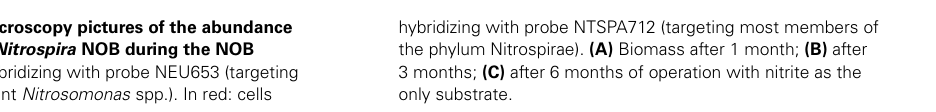
FIGURE 2 | Fluorescence microscopy pictures of the abundance of Nitrosomonas AOB and Nitrospira NOB during the NOB enrichment. In green: cell hybridizing with probe NEU653 (targeting most halophilic and halotolerant Nitrosomonas spp.). In red: cells